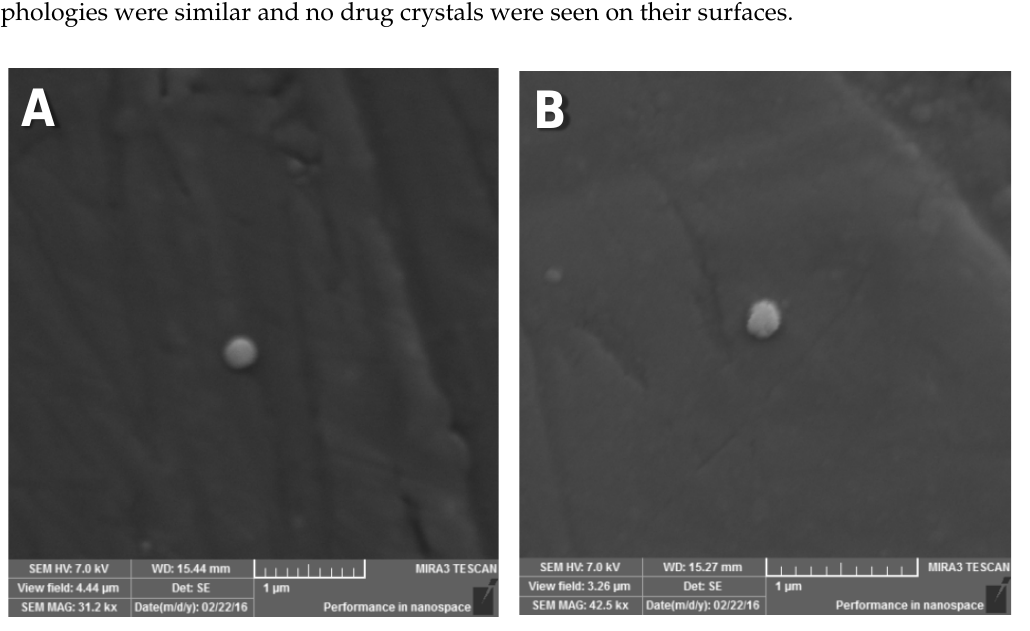
Figure 1. Photomicrographs of non-loaded and CUR and MTX-loaded NCs observed by FESEM: ( A ) NCUR/MTX-0 (31,200× magnification) and ( B ) NCUR/MTX-2 (42,500× magnification).